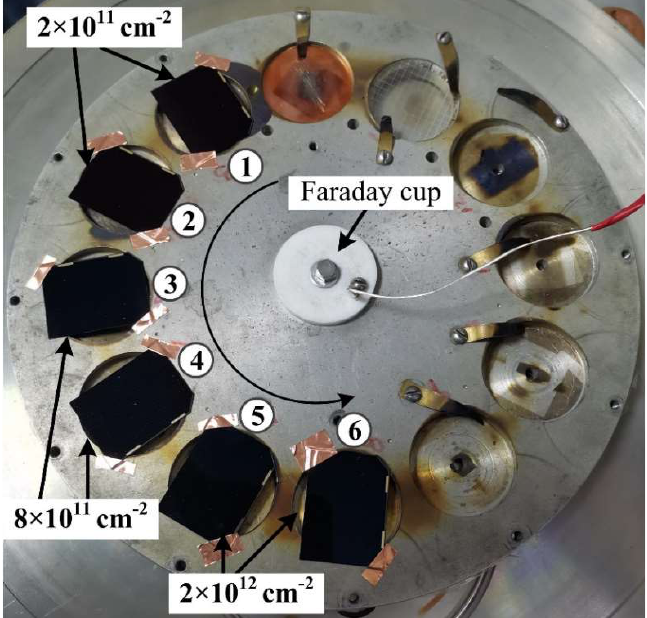
Figure 2. Photograph of the proton irradiation experiment. Six solar cells (No. 1–6) are used